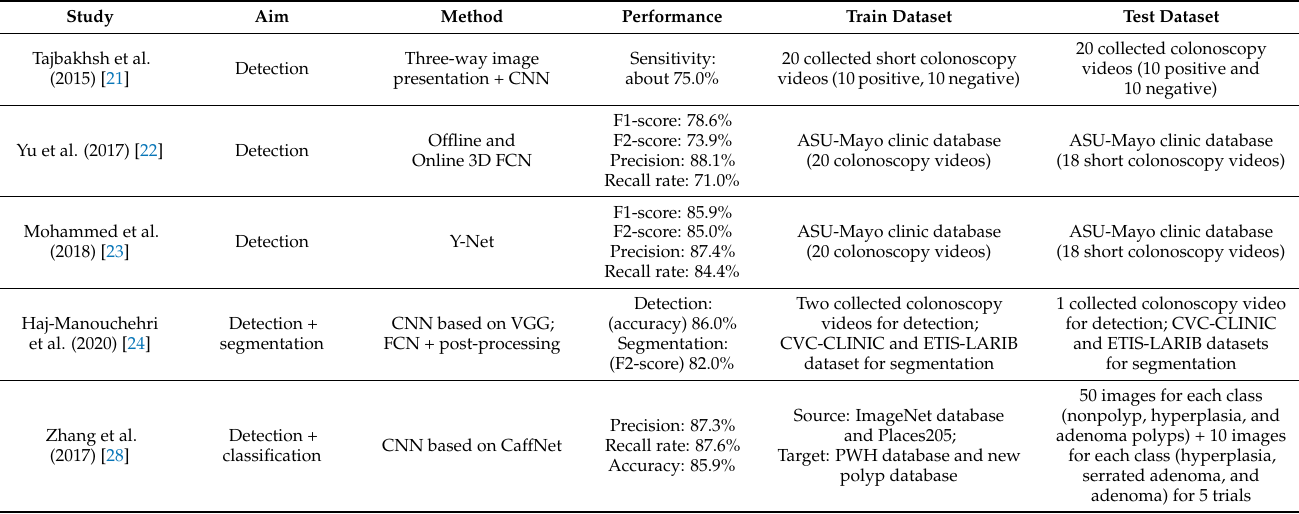
Table 2. Characteristics of models for the classification and detection of colon